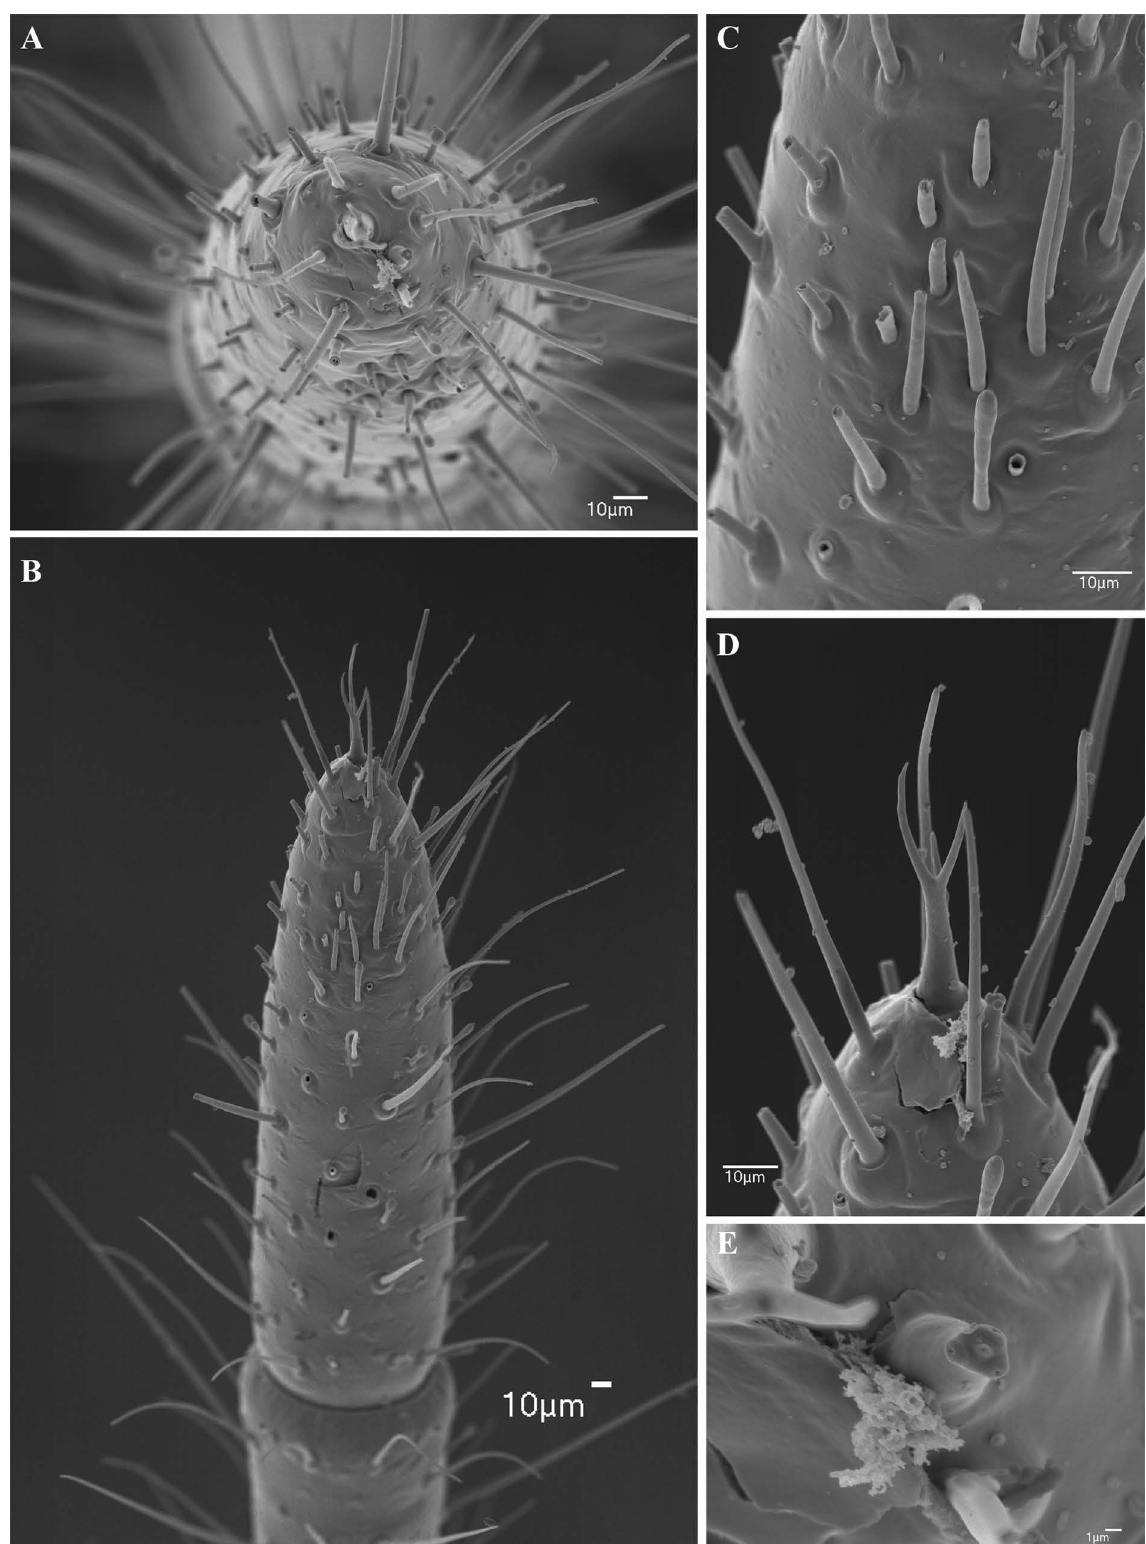
Fig. 98. Charinus elegans Weygoldt, 2006 (MHNG), antenniform leg I, ♂. A . Apex of distal article. B . Distal segment of tarsus, lateral view. C . Rod sensilla and olfactory setae. D . Apex of distal article of tarsus showing claw and tarsal organ. E . Detail of tarsal